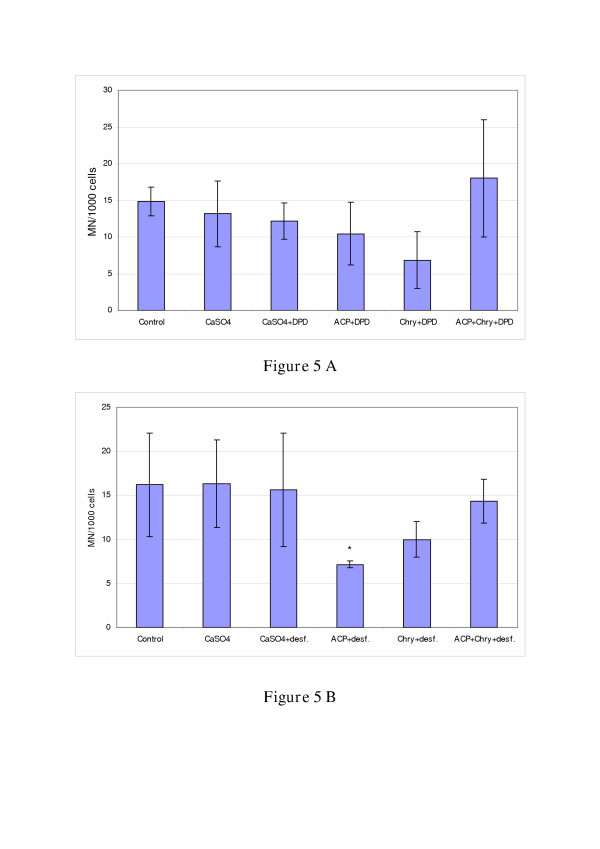
Reduction of micronucleus formation in exposed V79-cells after addition of the iron chelators 2,2'-dipyridyl (final concentration: 100 μM) (A) and desferal (final concentration: 100 μM) (B). The treatment of cells with 2,2'-DPD and desferal, respectively, was done simultaneously with the fiber and particle treatment (concentrations: 3 μg/cm2 CaSO4; 3 μg/cm2 asbestos cement; 1 μg/cm2 chrysotile; exposure time: 48 h).